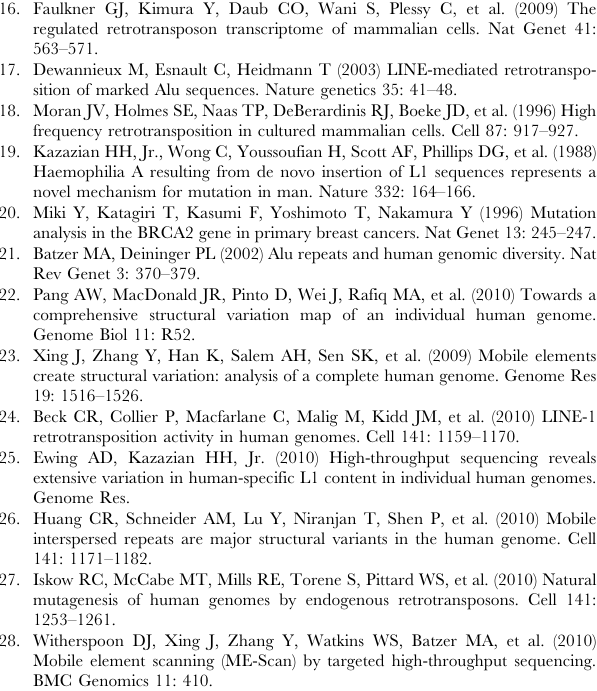
Table S7 Sub-family breakdown (external Excel file). Fragments from 1,105 of the Alu insertions were assembled into contigs spanning the Alu element to allow subfamily identification. The subfamilies are compared with those from the reference MEI detected as deletions and to the Venter MEI. (XLSX) Table S8 Non-reference MEI genotyping validation (external Excel file). Genotype contingency table for non-reference MEI vs. genotypes from PCR validation experiments. ‘‘0/0’’ are homozy- gous reference, ‘‘0/1’’ are heterozygous insertions, and ‘‘1/1’’ are homozygous insertions (VCF file genotype label convention). Counts in each box are the numbers of sites and samples with the corresponding combination of genotype from sequencing and PCR. The overall genotyping accuracy is the fraction of counts on the diagonal while the genotyping efficiency is the fraction of all genotyped sites & samples divided by sites 6 samples for the given pilot dataset. Only genotypes with Q $ 7 are included. The low coverage (a) accuracy is 87% and the efficiency is 57%. The trio pilot (b) accuracy is 95.7% and the genotyping efficiency is 89.9%. The improved genotyping performance for the trio pilot is a consequence of higher coverage. Table S9 MEI genotyping corrections. (external Excel file). a) Detection sensitivity. b) Genotyping efficiency with correction factors used in constructing the allele frequency spectra for each population and element type. c) Heterozygosity counts and correction factors for each sample and element family. (XLSX) Table S10 Loss of Function variants (external Excel file). Counts of insertions occurring within genes, UTR, and CDS regions annotated from Gencode version 3b. This table is partially shown as Table 1 in the main text. Only insertions with breakpoint confidence intervals entirely within the annotation region are counted. Any insertion candidate subsequently invalidated is not